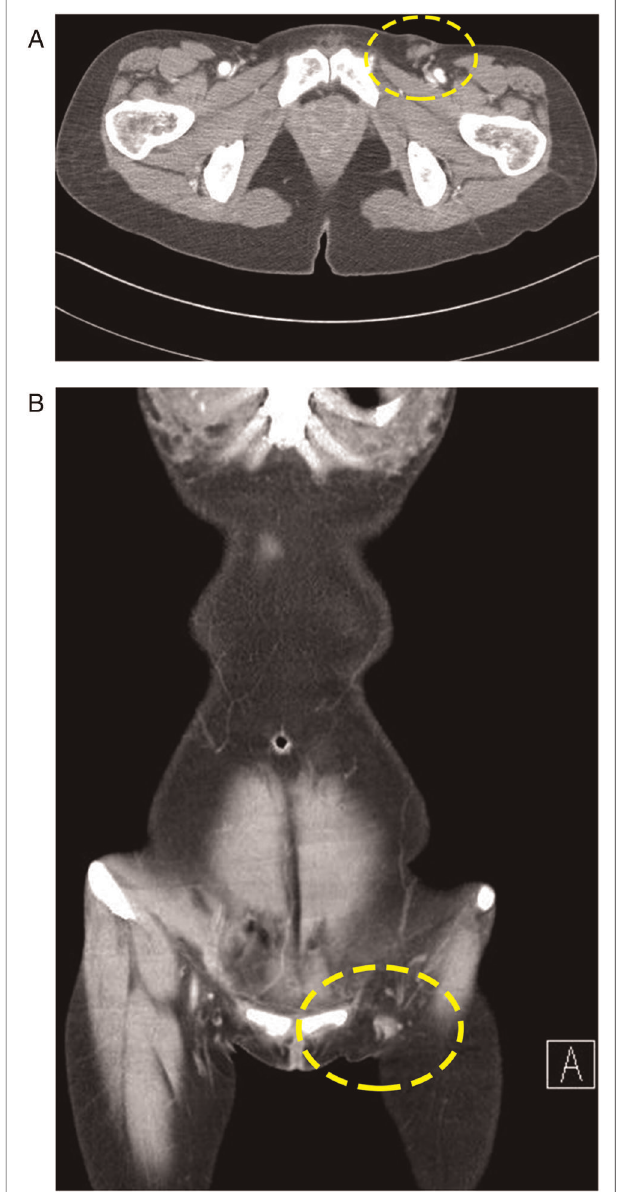
FIGURE 2 | Preoperative CT scan: ( A ) A 1.7-cm, regional conglomeration of dense, soft tissue is evident. ( B ) Lesion in (A) is surrounded by benign-looking adipose tissue.